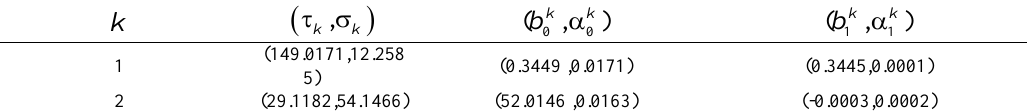
Table 6. Premise and consequence parameters obtained using FWGALP method for Example 2.